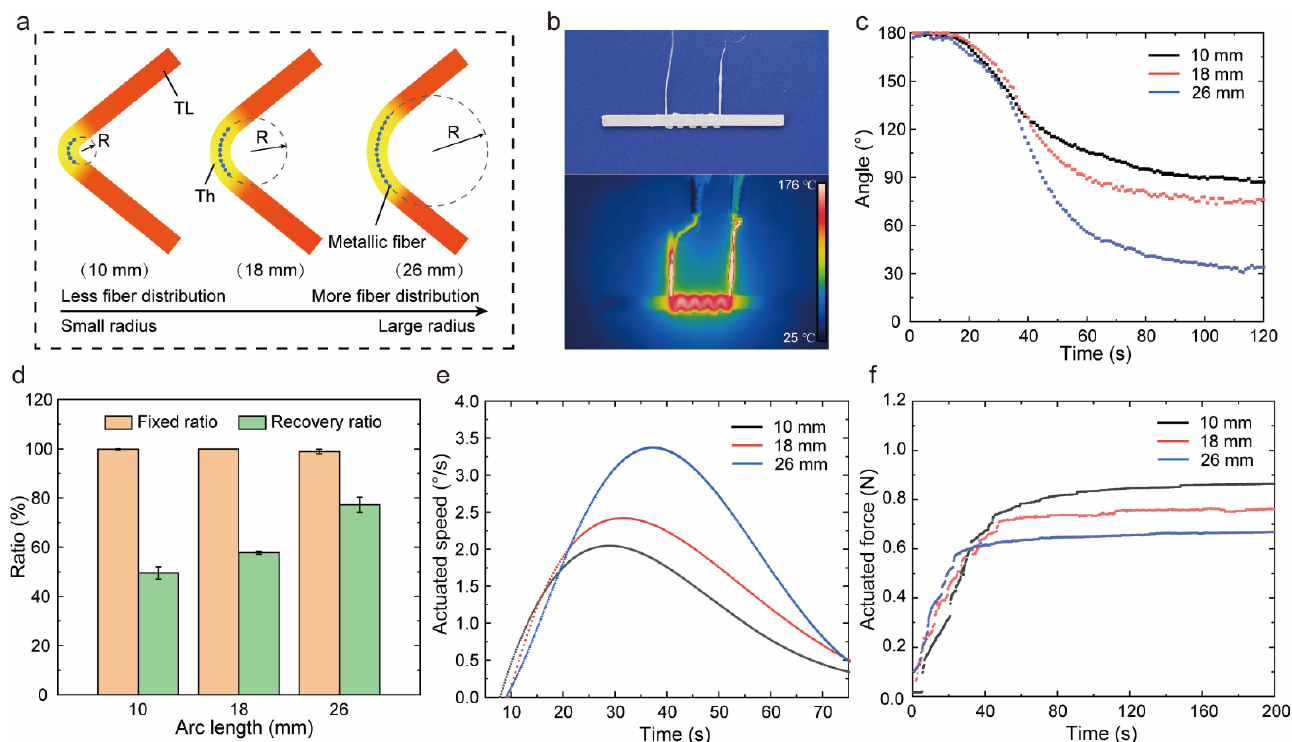
Figure 6. The effect of actuated length on shape memory properties and actuation performances. ( a ) The sketch of different actuated lengths in bending deformation. ( b ) The thermal imaging and optical photograph of sample with actuated length 18 mm. ( c ) The variation in angle for different actuated lengths. ( d ) The shape memory properties for different actuated lengths. ( e ) The angular speed for different actuated lengths. ( f ) The recovery force for different actuated lengths.